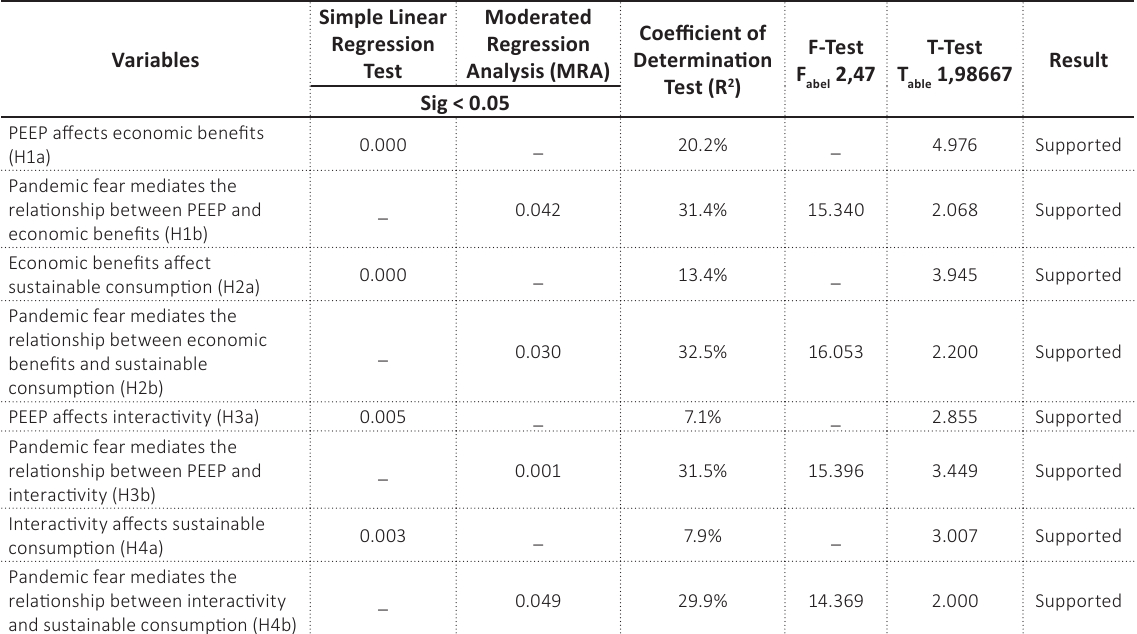
Source: SPSS 26 data